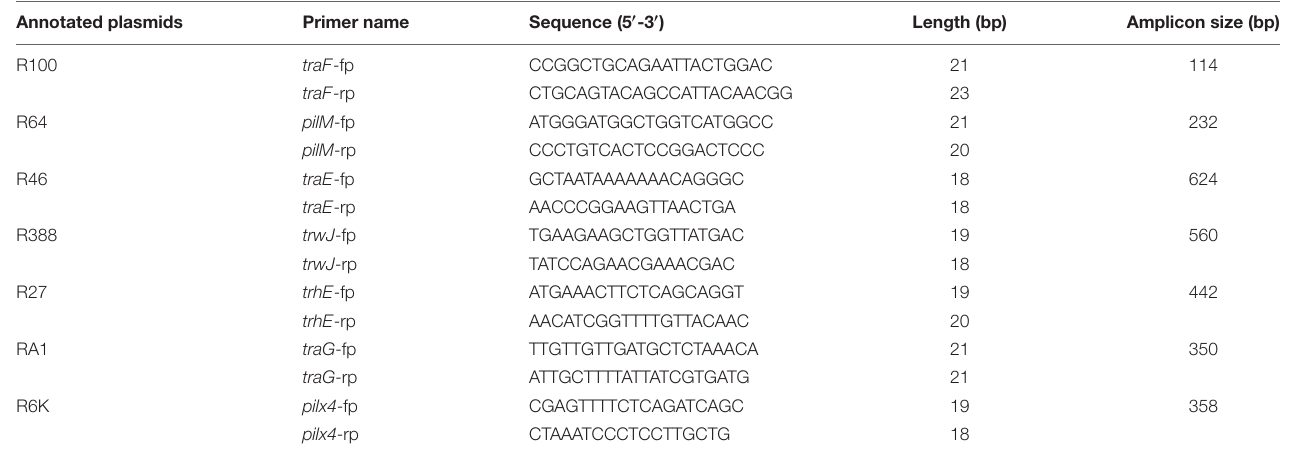
TABLE 1 | Primers used in this